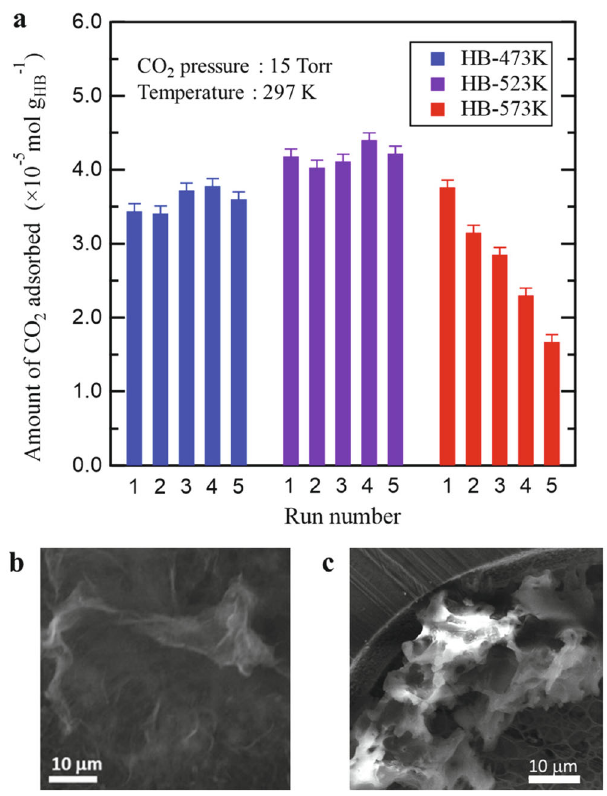
Fig. 2 Reproducibility of CO 2 adsorption on hydrogen boride (HB) sheets. a Amount of adsorbed CO 2 plotted as a function of the number of adsorption/desorption cycles. Adsorption was performed at 297 K in CO 2 atmosphere (15 Torr); desorption was performed for 1 h at each temperature in vacuum (473 K, 523 K, and 573 K for HB-473K, HB-523K, and HB-573K, respectively). Error bars result from the uncertainty in our measurement of pressure. b Scanning electron microscopy (SEM) image of pristine HB sheets. c SEM image of HB sheets after heating to 573 K in ultrahigh vacuum for 1